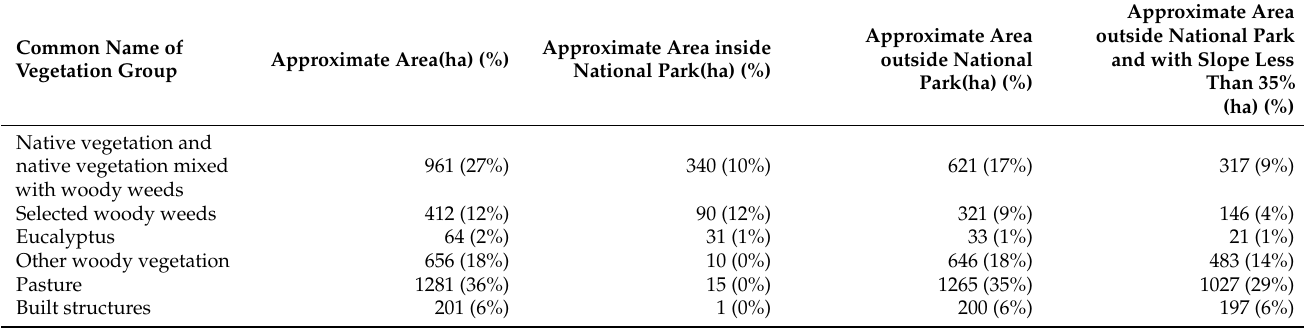
Table 3. For the purpose of these calculations, the national park includes the Norfolk Island Botanic Garden. Selected woody weeds are red guava, Hawaiian holly, Cotoneaster and African olive. Built structures include roads and